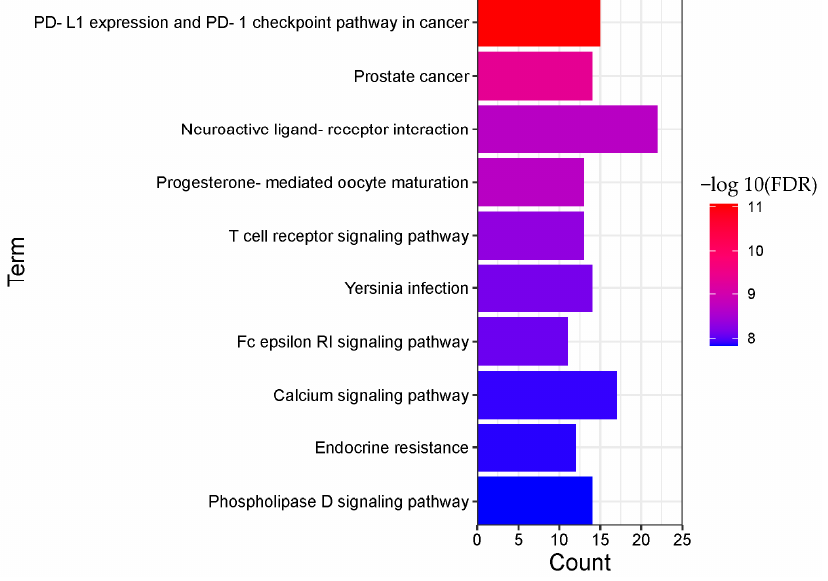
Figure 6. Pathway enrichment analysis result of BRU (TOP 10).